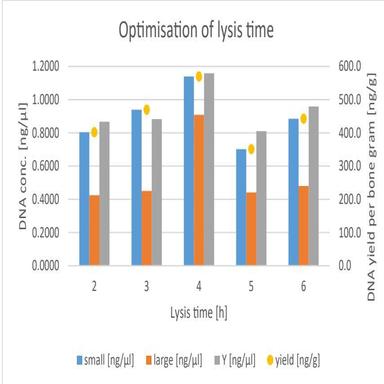
Results of DNA concentration measurement using qPCR (small autosomal DNA, large autosomal DNA, Y-DNA) for bone tissue with high DNA content compared to different lysis times. The graph also shows the resulting DNA yield per gram of bone.